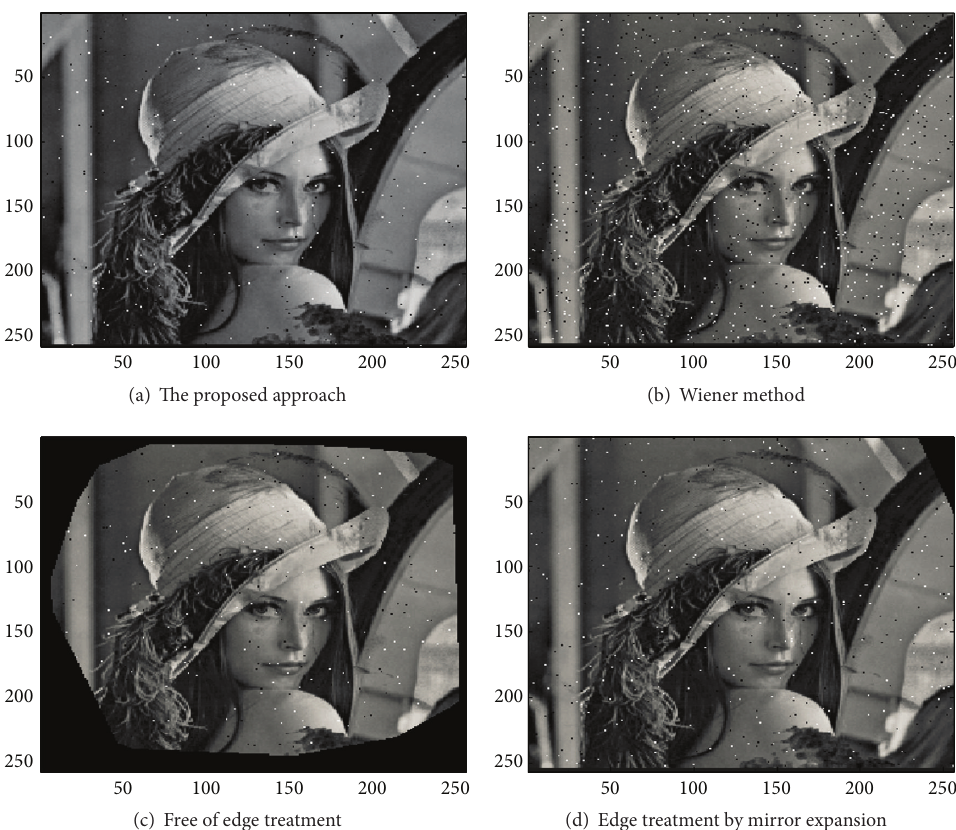
Figure 5: Comparison of denoising results for the image with salt and pepper noise.